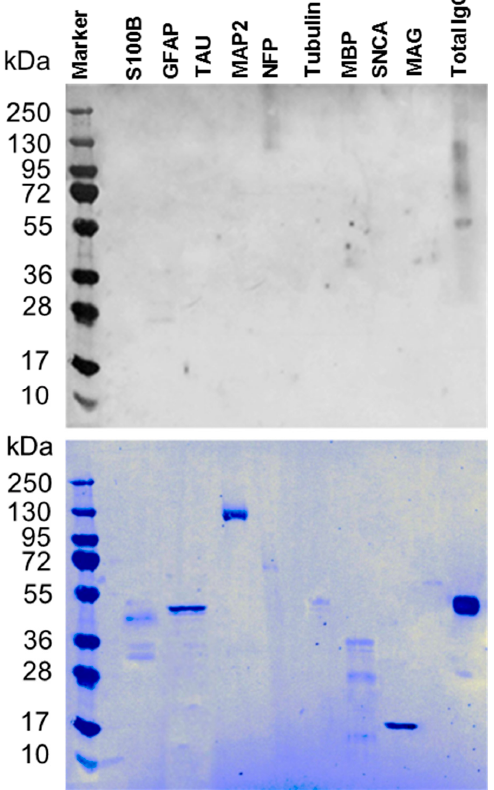
Figure 1. Specificity of the serum autoantibody. The specificity of the serum autoantibody against all tested neural proteins was carried out by protein / peptide competitive or absorption assay. Upper panel) Western blot from ASD-C following the absorption of the sera with S100B, GFAP, Tau, MAP2, NFP, Tubulin, MBP, SNCA and MAG proteins. The levels of autoantibodies against neuronal and glial proteins are negligible supporting the specificity of the assay. Lower panel) Commassie stain showing the proteins signals on the blot indicating that the sera were depleted from the autoantibodies by the adsorption